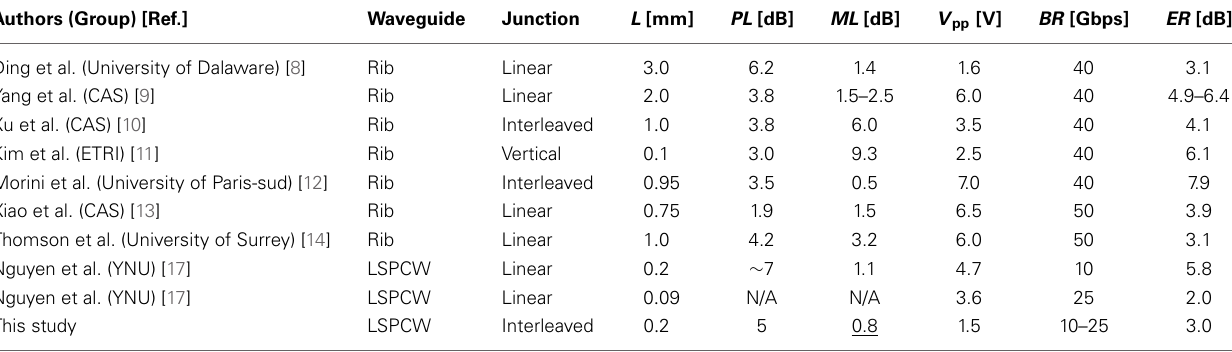
Table 1 | Comparison of performances of